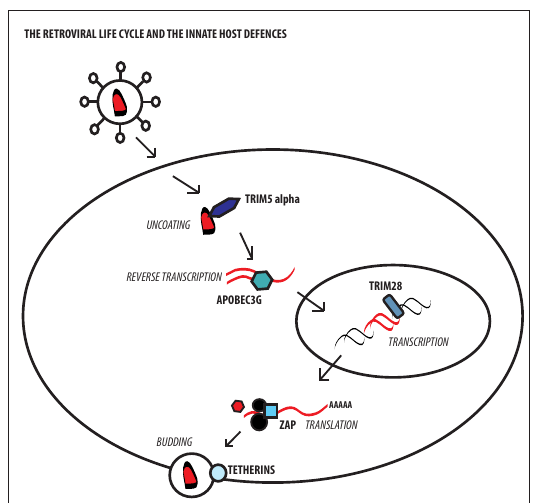
The retroviral life cycle and the innate host defences. The retroviral life cycle serves as a model for the interaction between retroelements and the cellular defences. In the early stages of the replication cycle, cellular defences act on the capsid at postentry (TRIM5 α ) and at reverse transcrip- tion (cytidine deaminases such as APOBEC3G).Transcription of the integrated genome can be silenced (TRIM28), or trans- lation of its RNA impaired (Zap). Late replication events (budding) can also be blocked